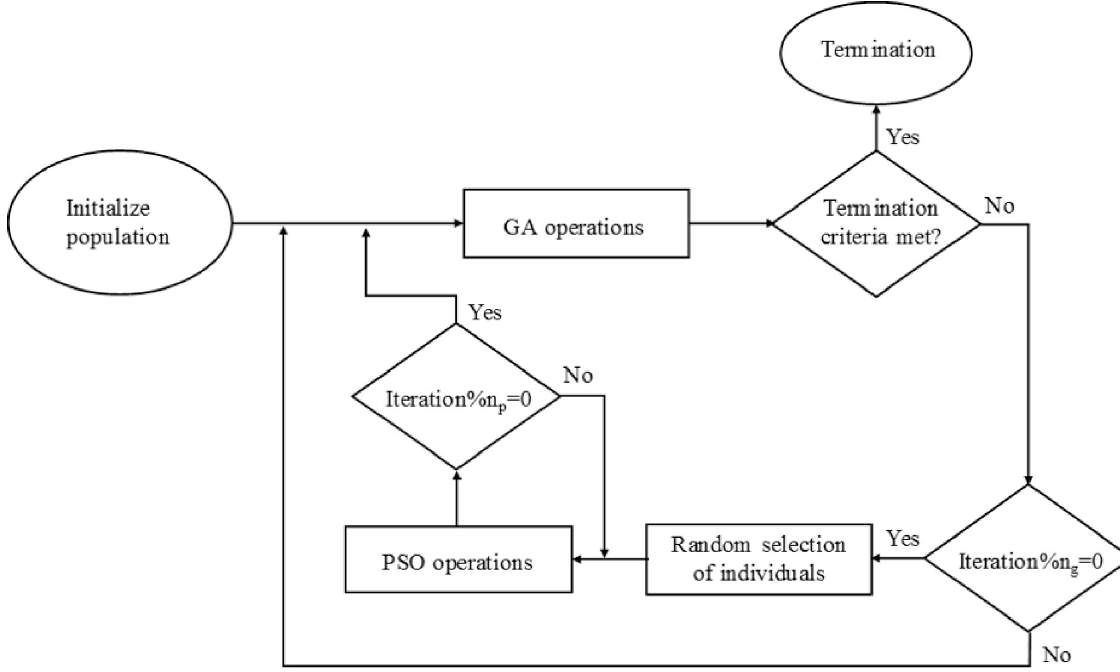
Fig 6. Flow chart for the proposed hybrid